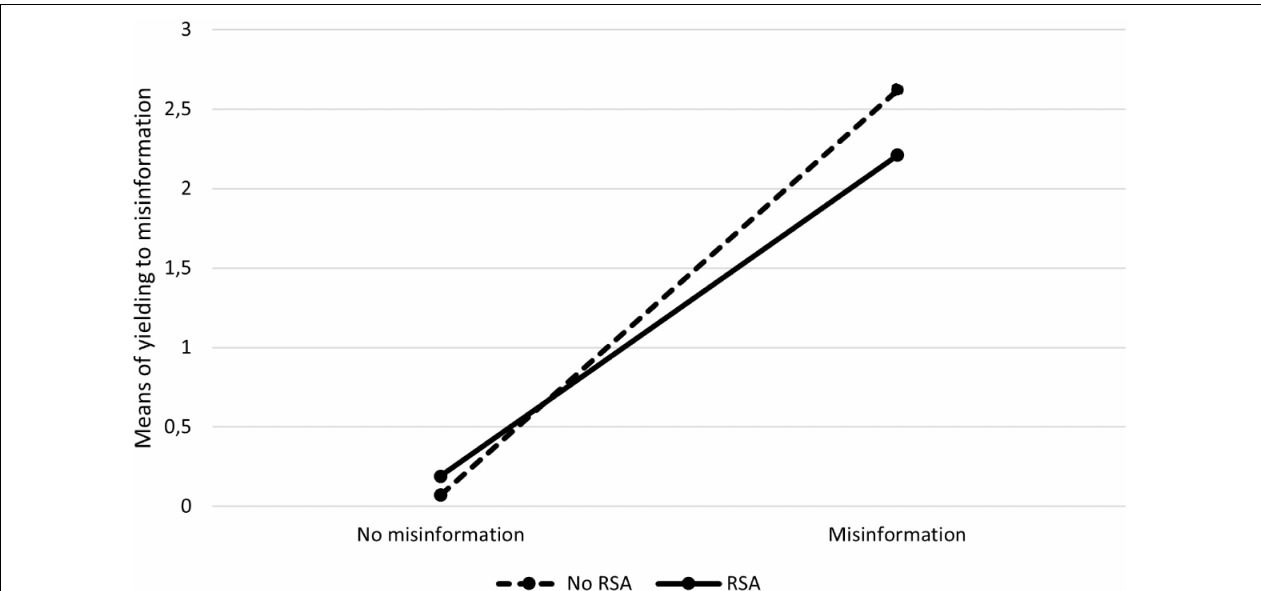
FIGURE 3 | Means of yielding to misinformation across experimental conditions in Experiment